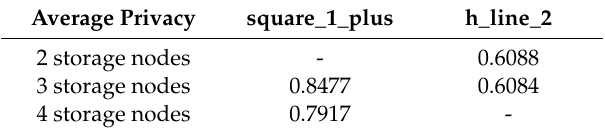
Figure 14. Evaluation results for dynamic clustering over the topology of 100 nodes for ( a ) 3 servers and square_1_plus trajectory, ( b ) 4 servers and square_1_plus trajectory, ( c ) 2 servers and h_line_2 trajectory, ( d ) 2 servers and h_line_2 trajectory. Table 3. Average privacy achieved by the walkthrough algorithm for the topology of 100 nodes.